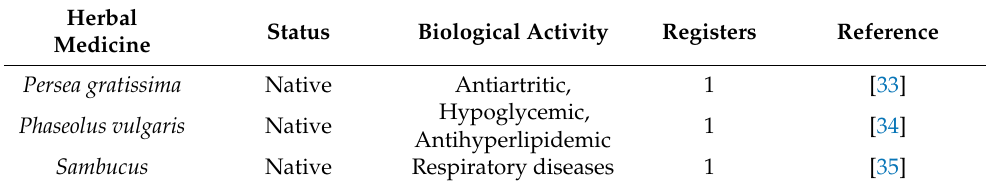
Table 2. Native plants used in herbal medicines with mainly biological activity and number of registers.